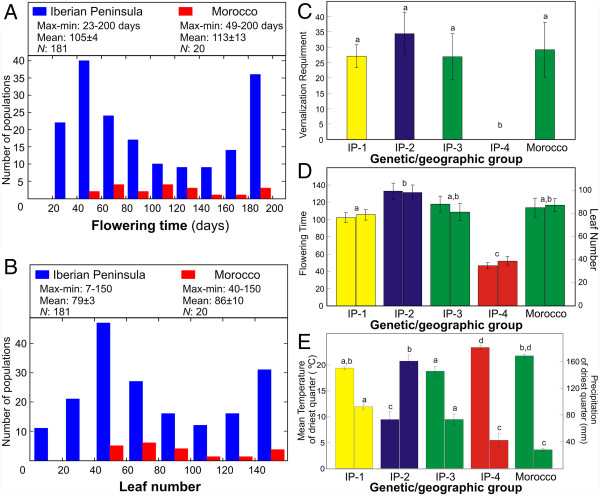
A. thaliana flowering and climatic variation in the south-western Mediterranean region. A) Flowering time and B) leaf number of Moroccan and Iberian accessions. C) Obligate vernalization requirement, D) flowering time (left column) and leaf number (right column), and E) mean temperature (left column) and precipitation (right column) of the driest quarter, in the four genetic groups detected with STRUCTURE in the Iberian Peninsula and in Morocco. In C-E, bars are the mean ± SE of the accessions assigned to each genetic group, except that group 3 is divided in Iberia (IP-3) and Morocco. Shared or different letters above bars indicate non-significant and significant differences between groups (P < 0.05) according to Tukey tests. Bar colors are similar to group colors shown in Figure 2.